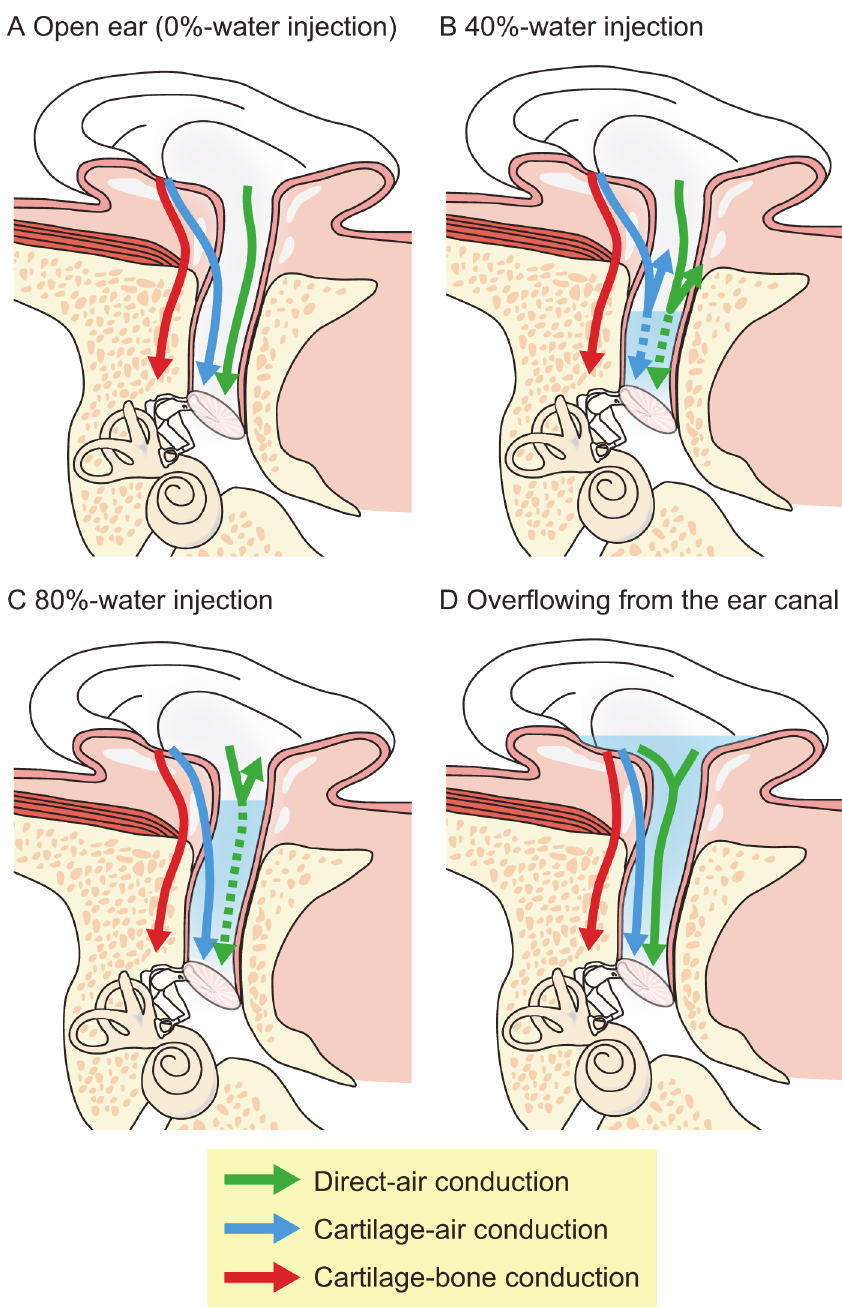
Fig 1. Sound transmission pathways in cartilage conduction. Part A shows three possible transmission pathways when the transducer is placed on the cavity of the concha [8, 9]. In the first pathway, vibrations of the transducer directly produces air-borne sound, some of which reaches the ear canal and is transmitted to the cochlea via the conventional pathway in air conduction (AC). This pathway is termed “ Direct-AC ” . In the second pathway, vibrations of the aural cartilage and soft tissue are transmitted to the cartilaginous portion. These vibrations induce an acoustic signal in the canal which is transmitted by AC to the eardrum. This pathway is termed “ Cartilage-AC ” . In the third pathway, vibrations of the aural cartilage and soft tissue are transmitted via the skull. This pathway is termed “ Cartilage-bone conduction ” . Part B, C, and D show the change in the sound transmission when the water is injected into the ear canal. When 40% of the ear canal is filled with water, the surface of the water probably levels at the bony potion. In this condition, the Direct-AC and Cartilage-AC are interrupted (Part B). When the water is additionally injected to 80% of the ear canal,